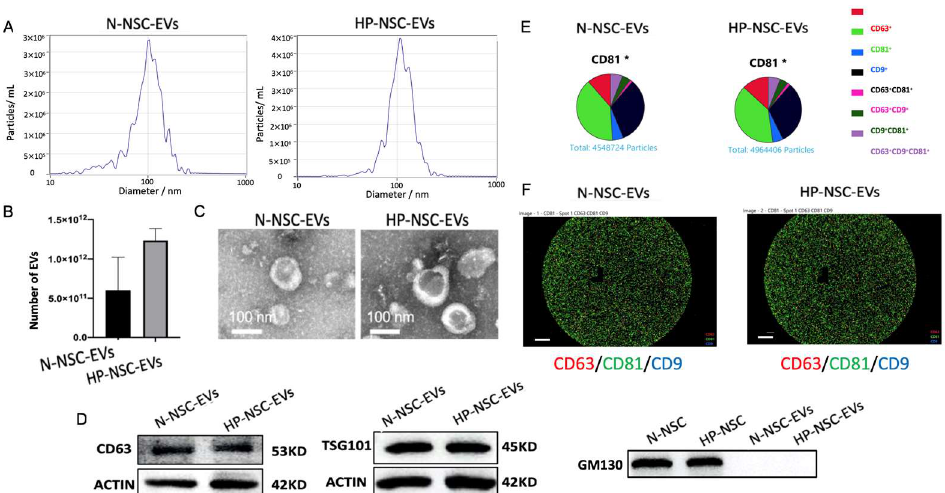
Figure 3. Characterization of normal vs. hypoxic preconditioned NSC-derived extracellular vesicles. ( A ). Particle size distribution measured by nanoparticle tracking analysis (NTA). ( B ) Concentration (particles/mL) of EVs measured by NTA. n = 4 NSCs isolated from mice per group, p = 0.0712 HP-NSC-EVs vs. N-NSC-EVs and number of EVs are expressed as means ± SD. ( C ) Normal vs. hypoxic preconditioned NSC EVs morphology identified by transmission electron microscopy (TEM). ( D ) Western blot analysis of EV surface markers, CD63, TSG101, and non-EV marker, GM130 (N = 4). ( E ) Both normal and HP-NSC-EVs were all positive for the three EV markers, CD63, CD9, and CD81. Co-expressions of EV markers were measured by probing captured EVs with the indicated secondary fluorescence-labelled antibody. ( F ) The specific EV markers from both normal and HP NSCs were analyzed by NanoSight NS300 and ExoView ® . Scale bar = 20 μm. 2.4. Proteomic Profiling of Normal vs. Hypoxic Preconditioned NSC-Derived EVs